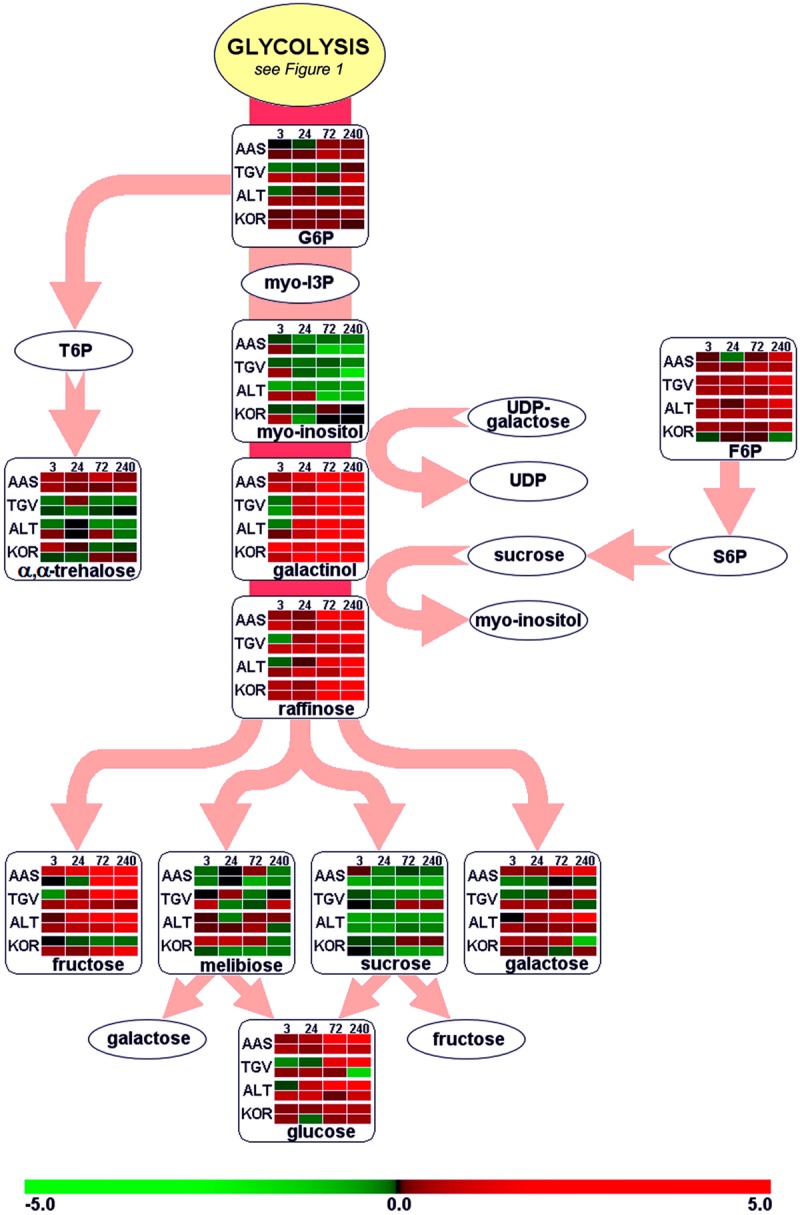
Functional regulation of raffinose biosynthesis. For further details about pathway map, experiments and color settings, see Figure 1. F6P, fructose-6-phosphate; G6P, glucose-6-phosphate; myo-I3P, myo-inositol-3-phosphate; S6P, sucrose-6-phosphate; T6P, trehalose-6-phosphate; UDP, uridine-diphosphate.